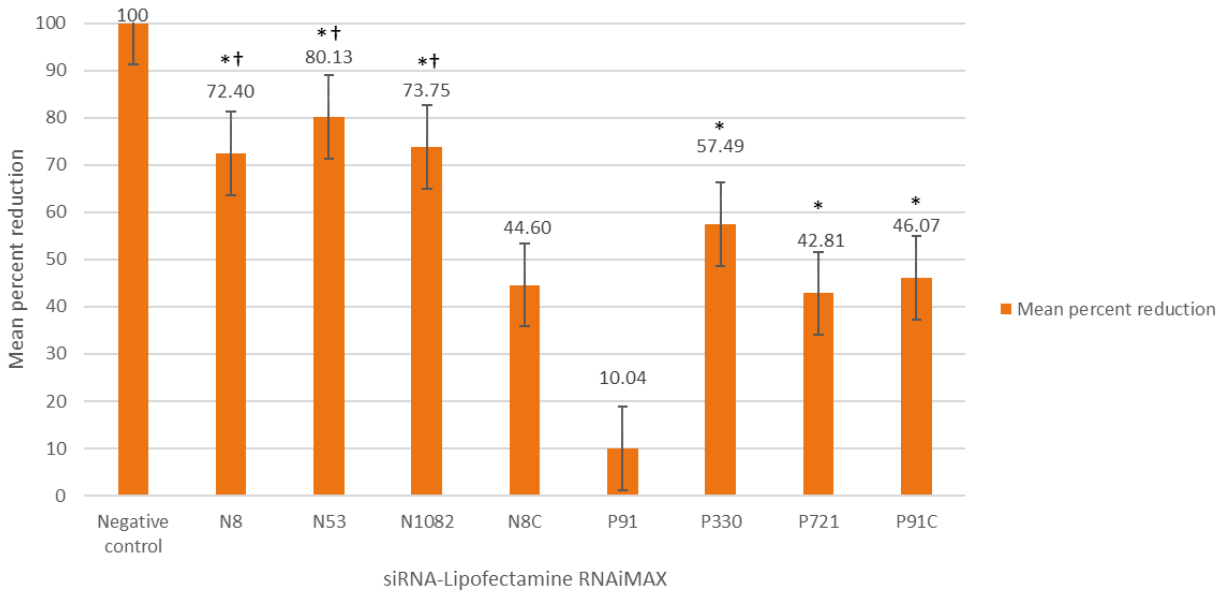
Figure 1. Mean percent reduction ( Y -axis) of siRNAs conjugated with Lipofectamine (final concentration 5 pM) targeting the N and P genes of RABV CVS-11 (50 MOI) with treatment occurring 2 h post infection. All of the experiments were undertaken in sextuplicate. * indicates significant reduction compared to the mean of the positive control (CVS-11 and Lipofectamine RNAi-MAX). N8 control (N8C) and P91 control (P91C) were scrambled siRNA sequences. † indicates significant difference ( p < 0.05) of the siRNAs compared with the scrambled control (P91C). Only P91C was compared in the two-tail t -test as this scrambled control demonstrated non-specific reduction compared with the positive control. For display purposes, the negative control has been set in relation to the positive control, but no reduction was observed for the negative control.